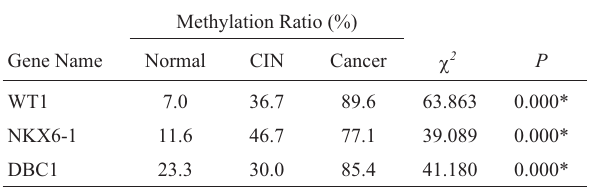
Table 3 - Infection status of HPV16/18. Table 4 - Methylation ratio of WT1, NKX6-1, DBC1.